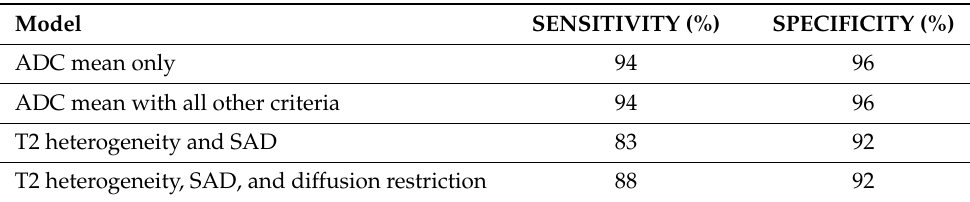
Table 3. Sensitivity and specificity of different parameters for the diagnosis of malignant lymphadenopa- thy for the models containing: ADC mean ( ≤ 1.095 × 10 − 3 mm 2 /s versus >1.095 × 10 − 3 mm 2 /s), SAD (short axis diameter), T2 heterogeneity, and diffusion